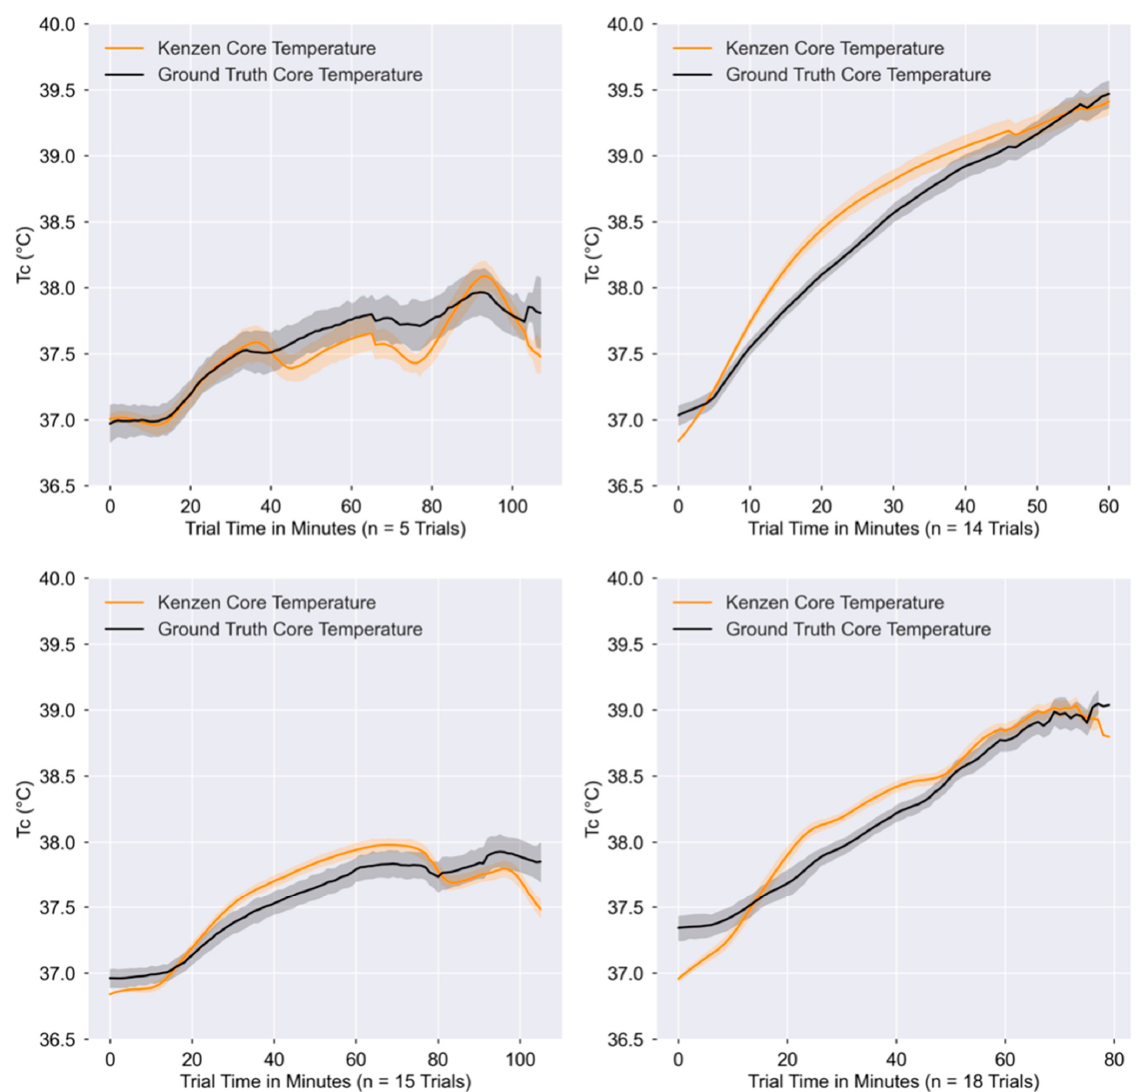
Figure 3. Time-averaged plot of Kenzen vs. ground truth T C for each Study 1–4. These plots are a visual representation of the Kenzen T C (orange) vs. ground truth T C (black). Trials from each Study were time-aligned, where the trial start was minute 0, and each point represents the minute-based average of all trials within that specific study. Error bands (light orange and gray shading around the mean lines) represent the 68% confidence interval ( ± 1 SD). Study 1 ( top left ), Study 2 ( top right ), Study 3 ( bottom left ), Study 4 ( bottom right ).